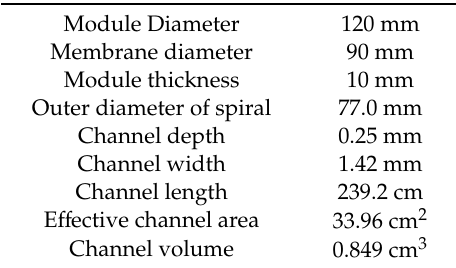
Table 3. Geometric properties of spiral